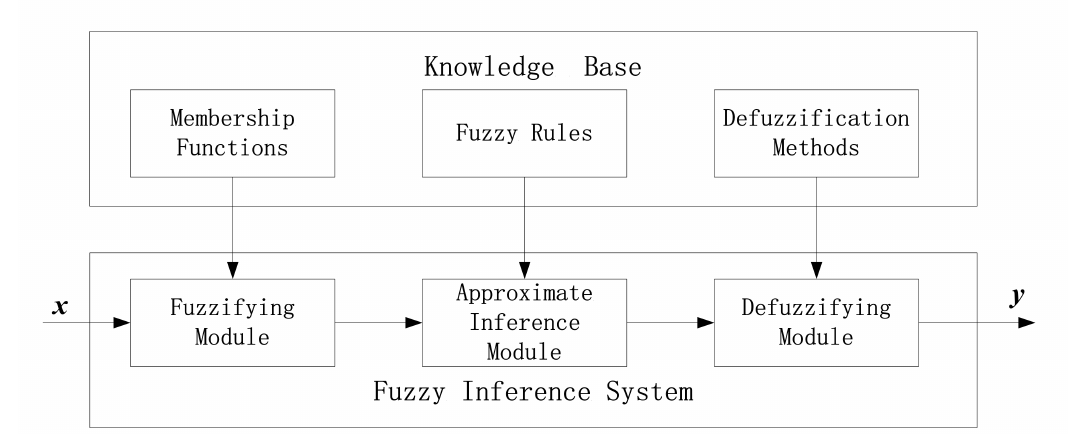
Figure 1. Schematic diagram of a standard fuzzy logic system.